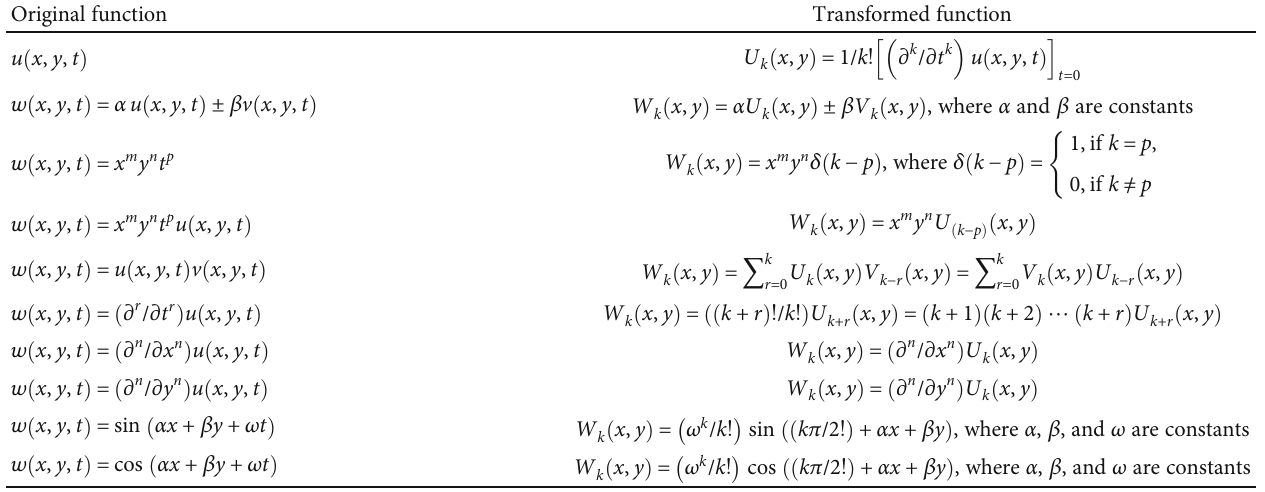
Table 1: The fundamental mathematical operations of RDTM [37, 41,